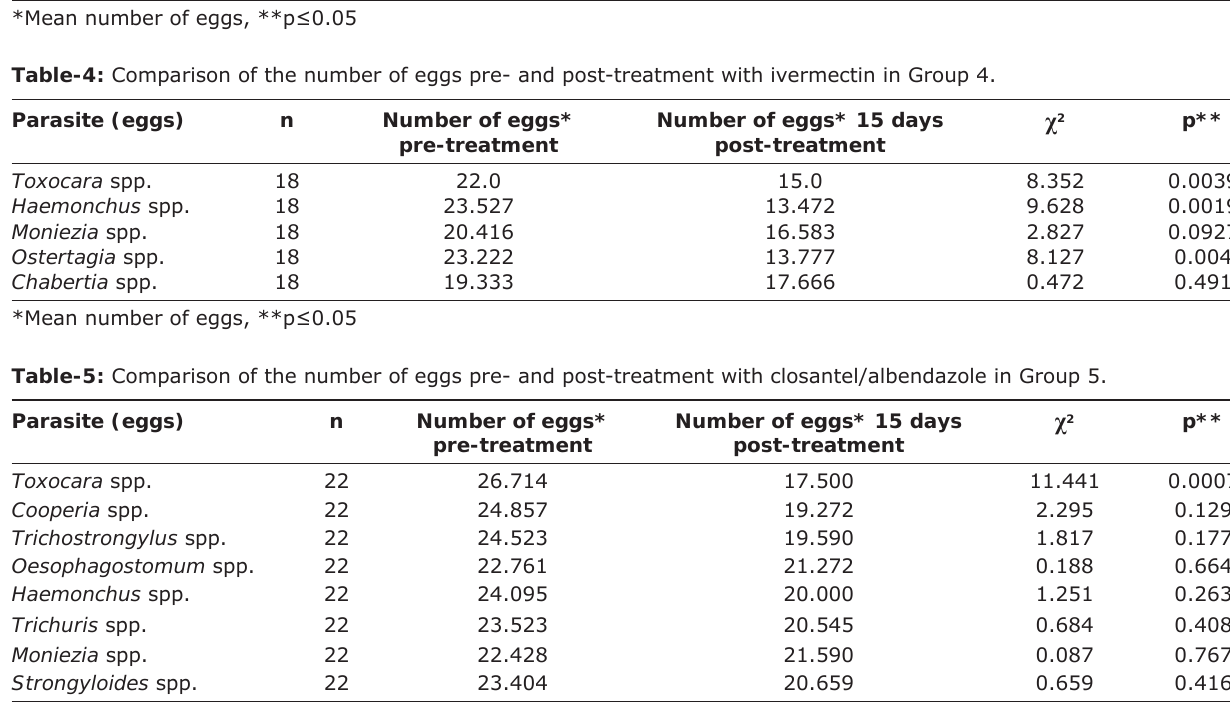
Table-3: Comparison of the number of eggs pre- and post-treatment with closantel sodium in Group 3. Parasite (eggs) n Number of eggs* Toxocara spp. Haemonchus spp. Ostertagia spp. Chabertia spp.